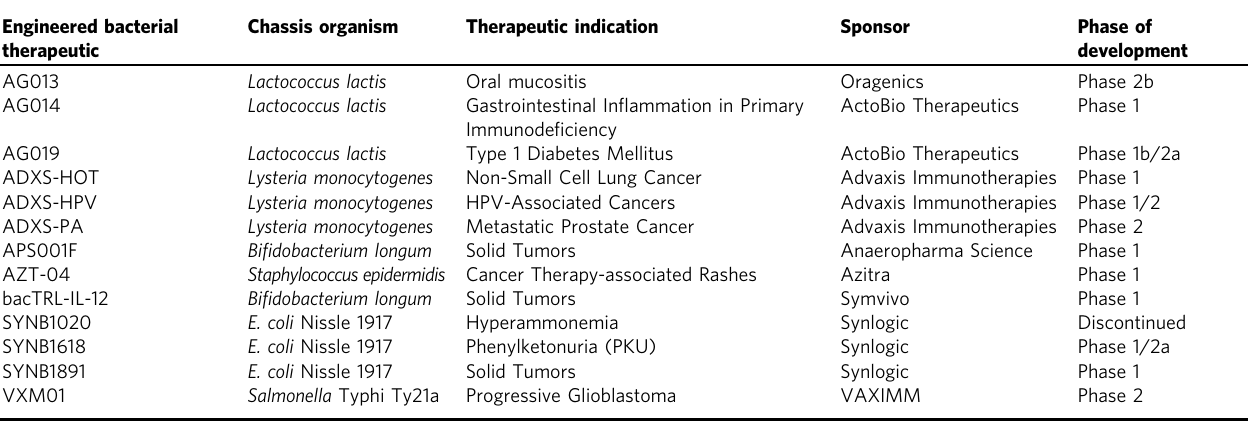
List of engineered bacterial therapeutics in clinical development, describing the chassis organism, therapeutic indication, and the organization sponsoring